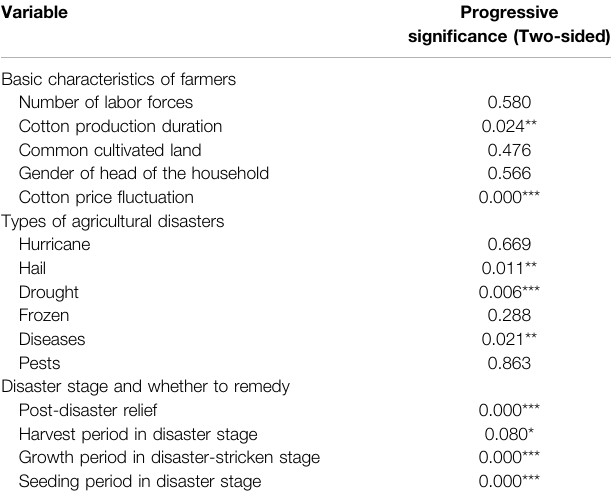
TABLE 4 | Estimation results of binary logistic